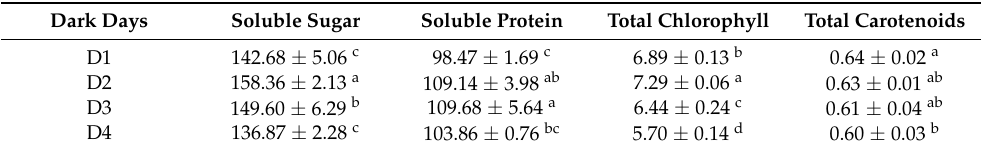
Table 1. Soluble sugar, soluble protein, chlorophyll, and carotenoids content in different days of dark treatment of mustard sprouts (mg g − 1 ).